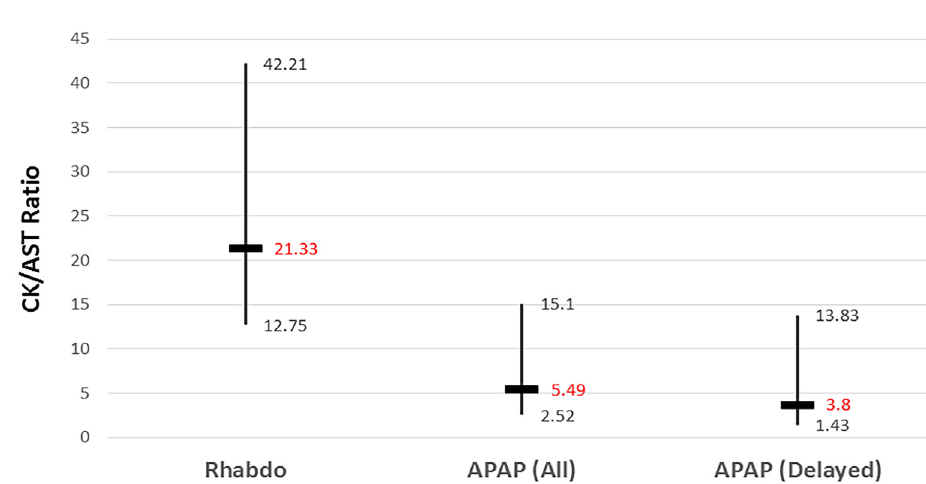
Figure 2. CK/AST ratios of the three patient groups. AST , aminotransferase; CK , creatine kinase; Rhabdo , rhabdomyolysis group; APAP (all) , all patients with acetaminophen overdose; APAP (delayed) , patients with delayed acetaminophen toxicity. Vertical bars indicate interquartile range of values; horizontal bars indicate median